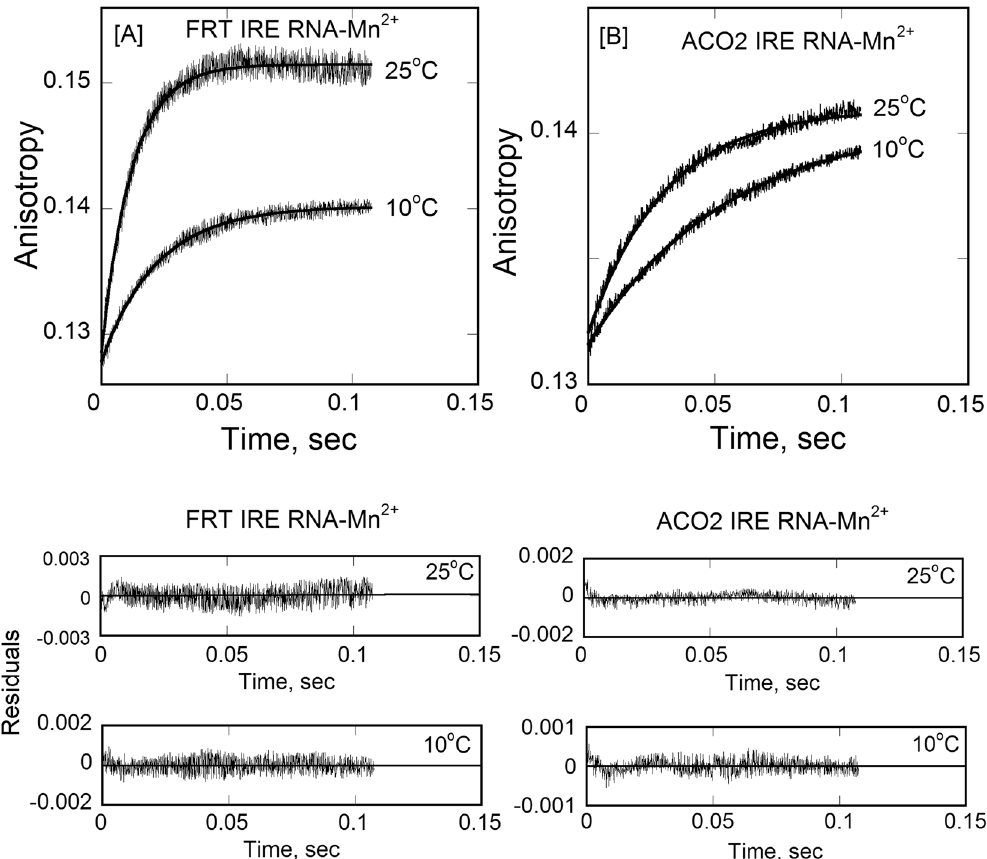
Figure 5. Temperature dependent kinetics of IRP1 binding with FI FRT IRE-RNA-Mn 2 + and FI ACO2 IRE- RNA-Mn 2 + . Representative kinetic data show the time-dependent increase in anisotropy after ( A ) FRT IRE-RNA-Mn 2 + and ( B ) ACO2 IRE-RNA-Mn 2 + had been mixed with IRP1 protein at temperature 25 °C and 10 °C. Concentration of Mn 2 + was 50 µ M. FRT and ACO2 IRE-RNA concentrations was 50 nM (final) and the IRP1 concentration was 1 µ M (final). The solid line represents the fitted curve for single-exponential function. Residuals for the fits are shown in the bottom panels. The experimental conditions are described in Experimental